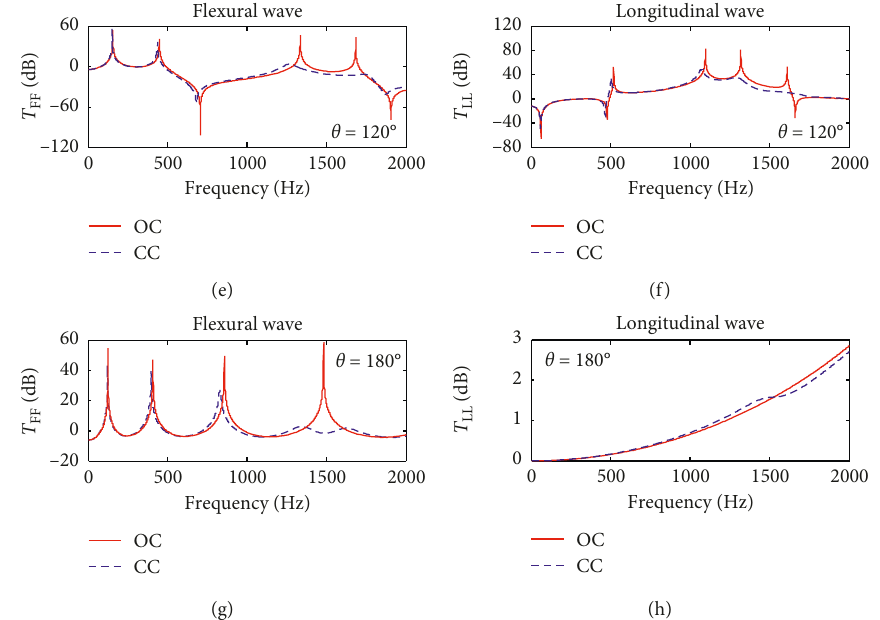
Figure 10: Variation of vibration transmissibility with intersection angle θ . For comparison, both attenuation constants and vibration transmissibility of flexural and longitudinal waves with open circuits (OC) and closed circuits (CC, L � 0.4H and R � 800 Ω ) are presented.